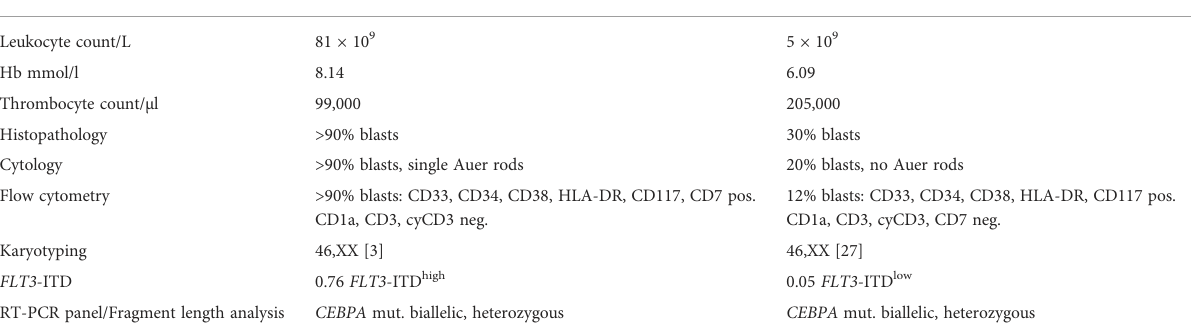
TABLE 1 Clinical